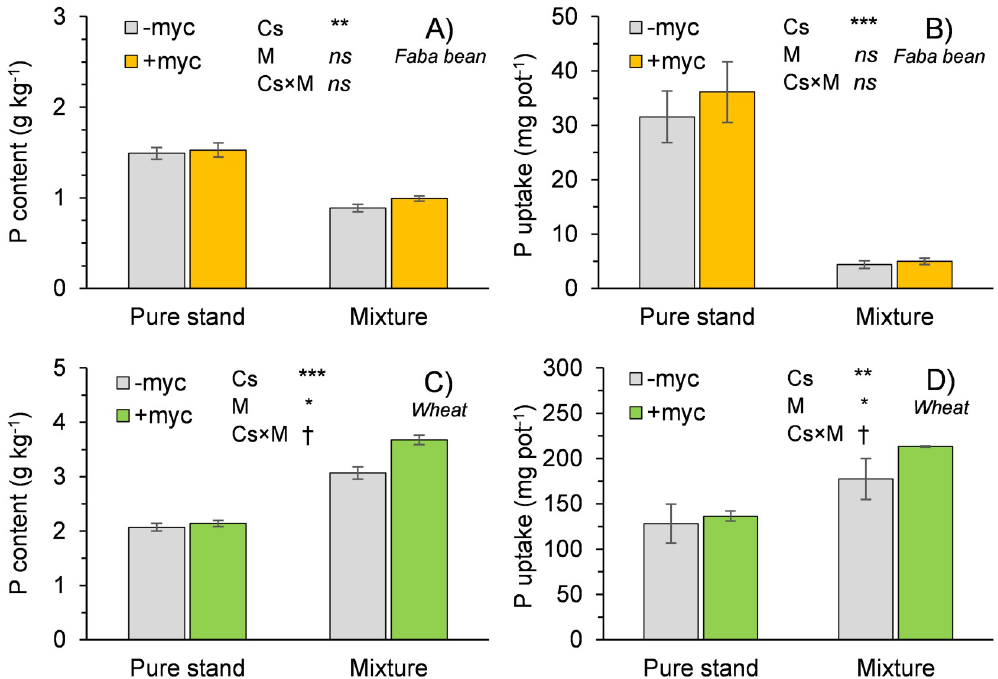
Fig 2. Phosphorus content and uptake of faba bean (A and B) and wheat (C and D) grown in pure stand and in mixture (values relative to aboveground biomass). Cs, cropping system (pure stand, mixture); M, absence (–myc) or presence (+myc) of arbuscular mycorrhizal fungi (AMF). †, � , �� , and ��� indicate significant differences at P � 0.10, 0.05, 0.01, and 0.001, respectively; ns indicates nonsignificant differences. Vertical bars indicate standard errors of each mean value (n = 5).